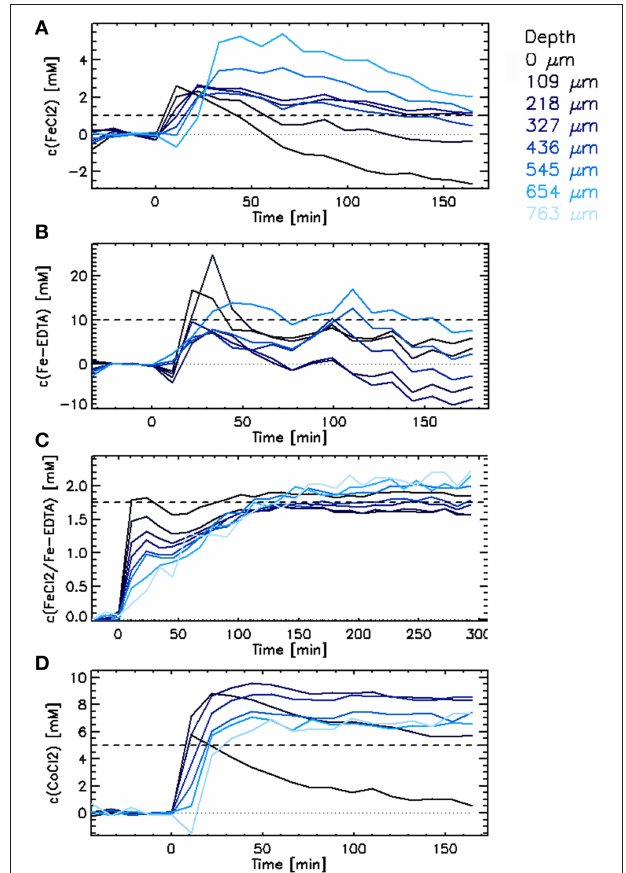
FIGURE 4 | A single T 1 (A), T 2 (B), and final concentration (C) profile through a single granule comparing the initial values ( + ) with the values after exposure to a 0.5mmol · L − 1 [GdDTPA] 2 − solution ( ♦ ).